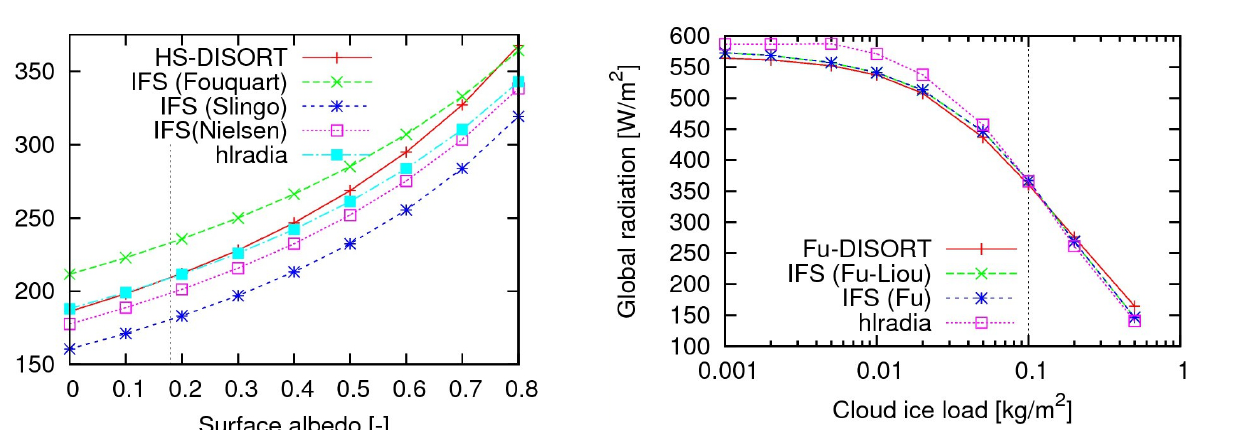
Figure 20. As for Fig. 10 but for surface albedo for the case of a cloud of medium thickness (experiment 6). The vertical dashed line at 0.18 marks the reference albedo used in experiments 4 and 5.